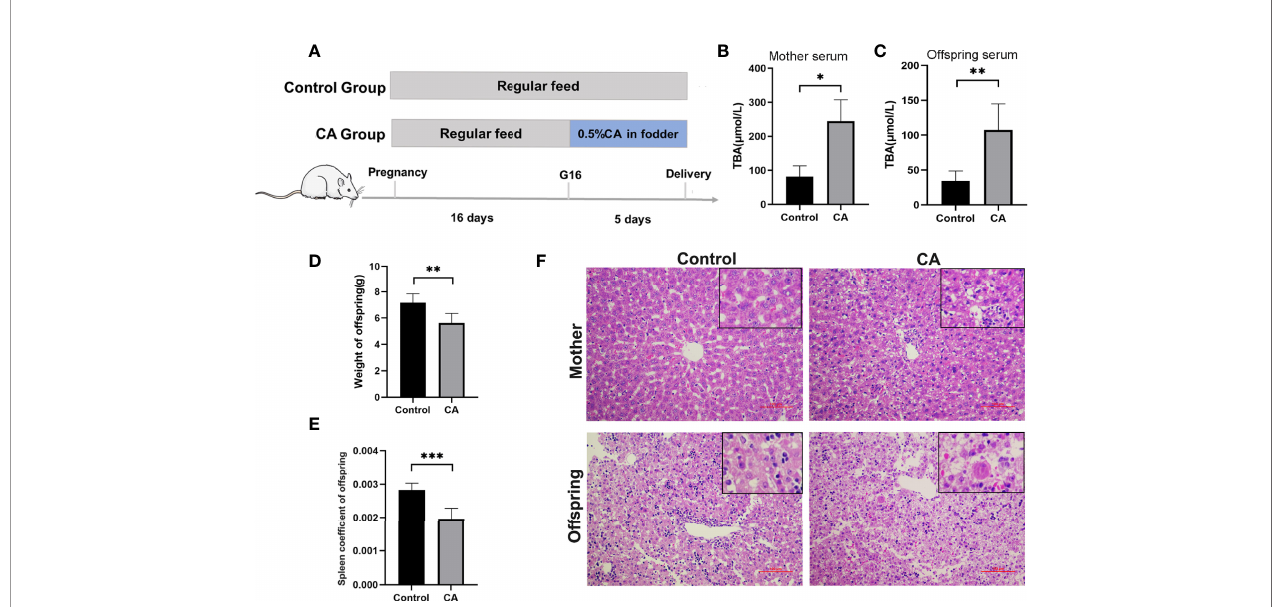
FIGURE 2 | Maternal cholestasis during pregnancy affects adverse fetal outcomes in mammals. (A) Flow diagram of the experimental procedure. (B) Comparison of total bile acid in mother serum between two groups. (C) Comparison of total bile acid in fetal serum between two groups. (D) Comparison of offspring weight between two groups. (E) Comparison of offspring spleen index between two groups. (F) Microscopic observation of the ileum tissue with hematoxylin and eosin (HE) staining. Scale bar, 100 mm. Magni fi cation, ×200 and ×400(insets). *p < 0.05, **p < 0.01, ***p<0.001. N =